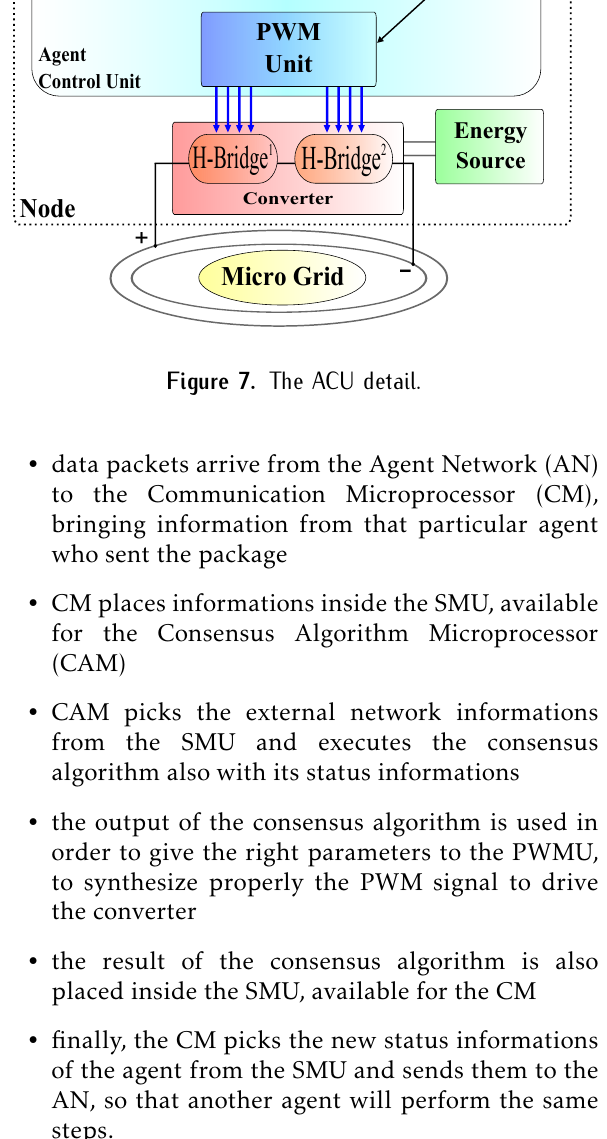
Figure 8. The single Agent developed in Matlab/Simulink